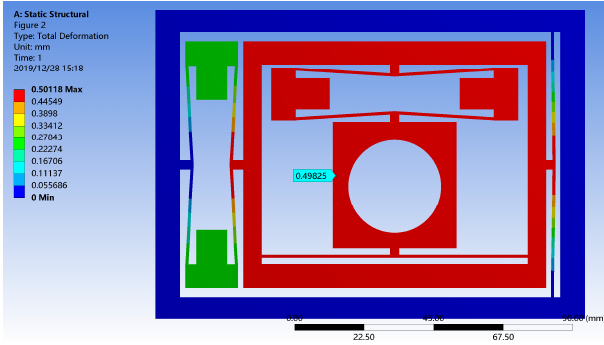
Figure 12. The displacement simulation of micro-positioning platform in the X direction.